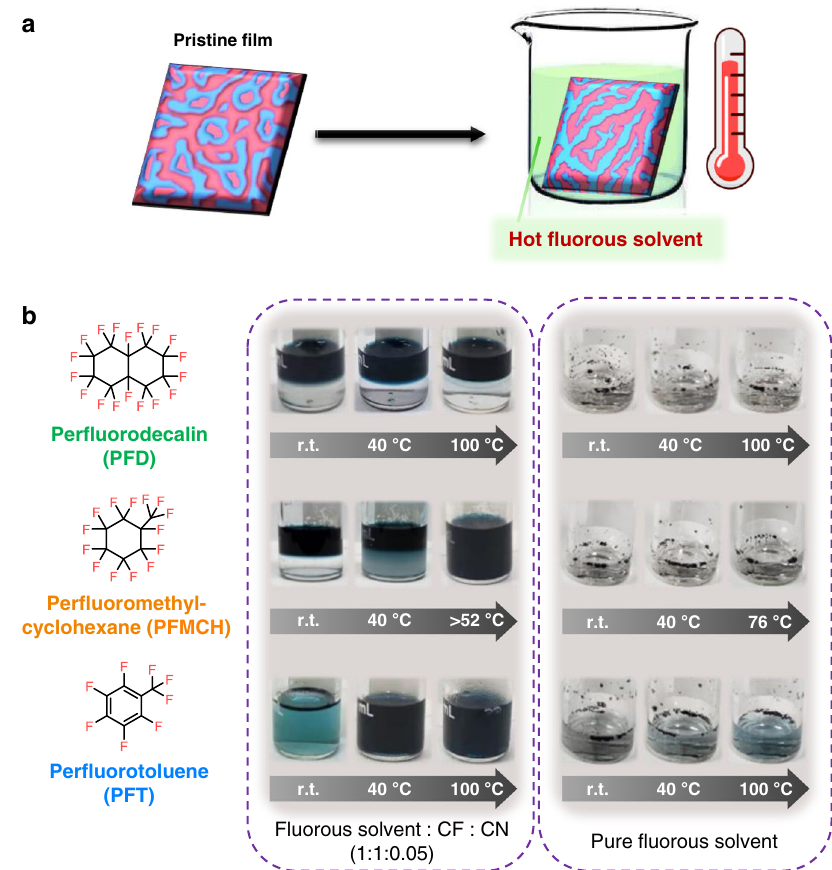
Fig. 1 Schematic illustration and temperature-dependent miscibility of fl uorous solvents. a Schematic illustration of the hot fl uorous solvent soaking (HFSS) approach. b Chemical structures of three fl uorous solvents. Temperature-dependent miscibility of fl uorous solvents and chloroform (CF)/ chloronaphthalene (CN) (v/v, 1:1:0.05) (Y6 as a color agent dissolved in chloroform) and solubility of Y6 in fl uorous